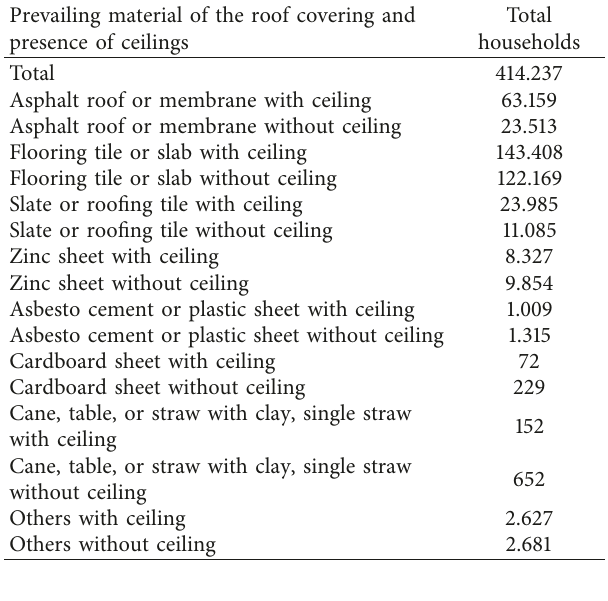
Table 1: Types of house cover used in the province of C´ordoba, Argentina [16].